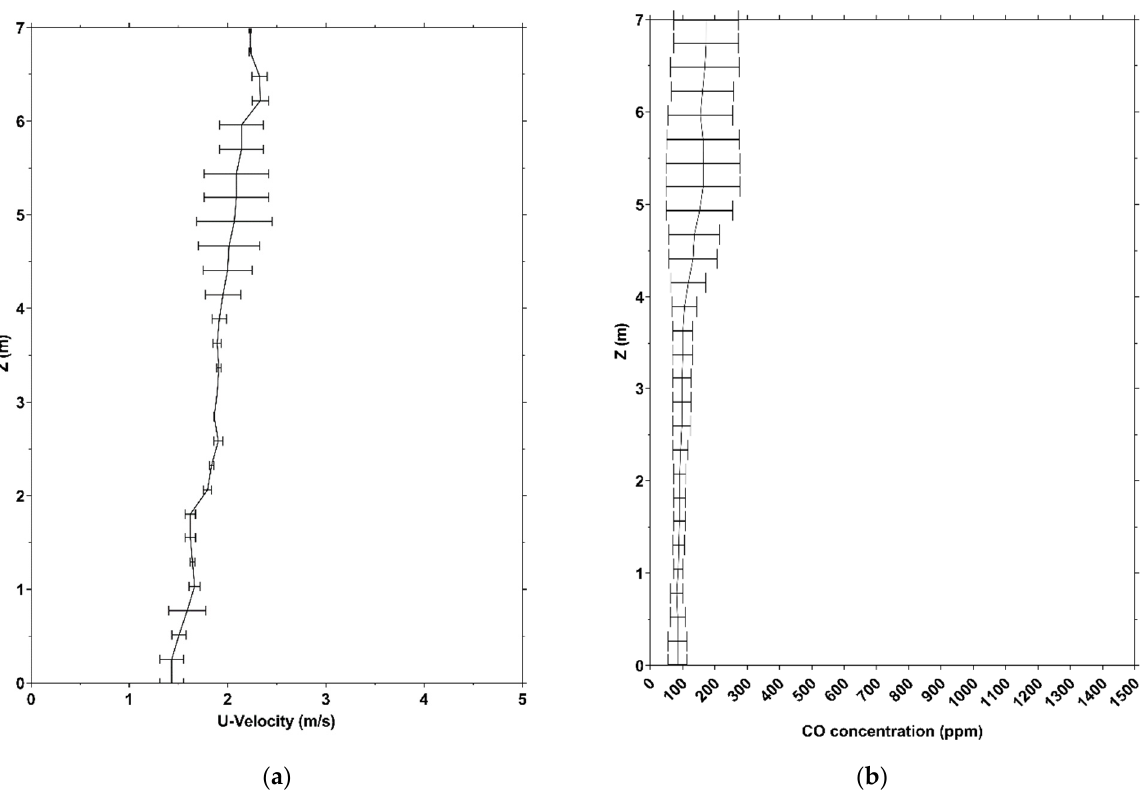
Figure 2. ( a ) Comparison of the grid convergence index (GCI) for the U mean velocity and ( b ) mean carbon monoxide concentration for the medium and fine mesh in the symmetry plane of the tunnel, with coordinates (x = 1100 m, y = 5.5 m, and z = from 0 to 7 m) and 28 sampling points. The grid independence examined the U velocity and carbon monoxide concentration values. The values were extracted by a line, downwind of the fire source, in the symmetry plane of the tunnel with coordinates (x = 1100 m, y = 5.5 m, and z = from 0 to 7 m) with 28 sampling points.